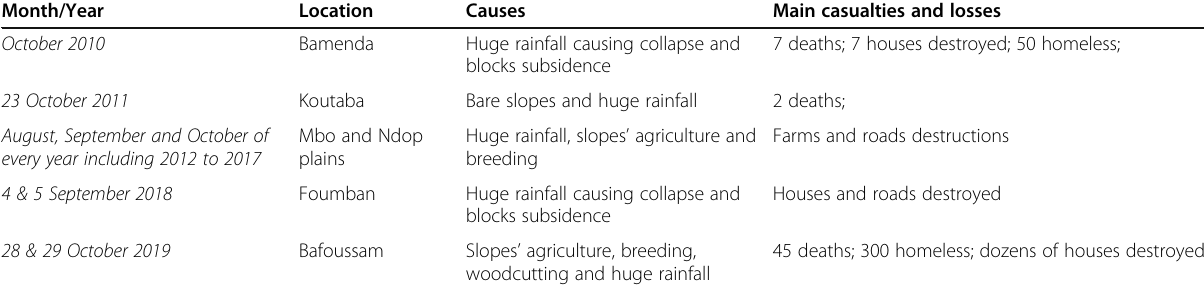
Table 4 Landslide causes and consequences in Cameroon to the best of recording (Continued)